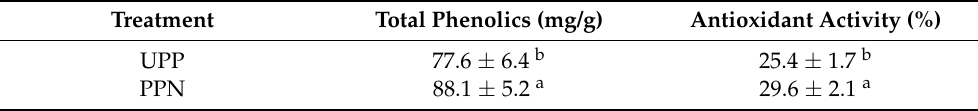
Table 3. Total phenolic content and antioxidant activity of both UPP and PPN. Treatment Total Phenolics (mg/g) Antioxidant Activity (%) UPP